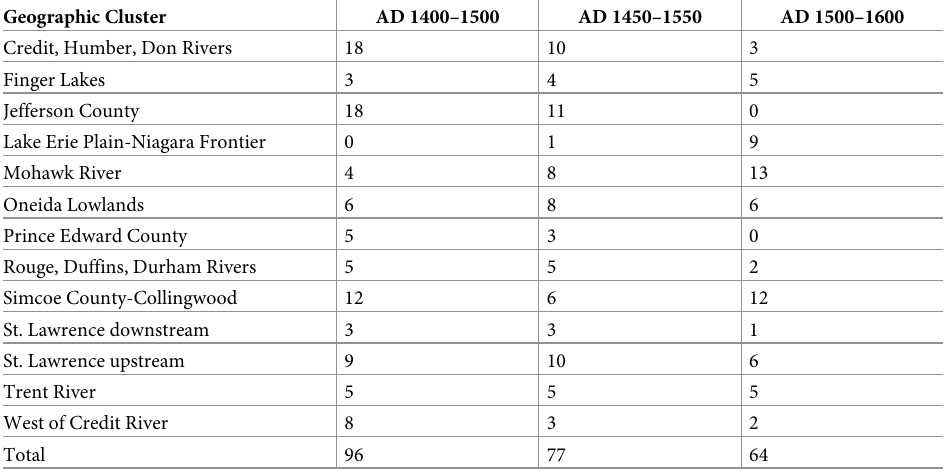
Table 7. Number of sites represented in geographical clusters by 100-year graph. Geographic